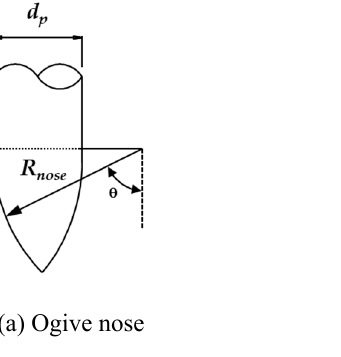
Figure 1. Nose shape and definition (redrawn from Chen and Li [26]).